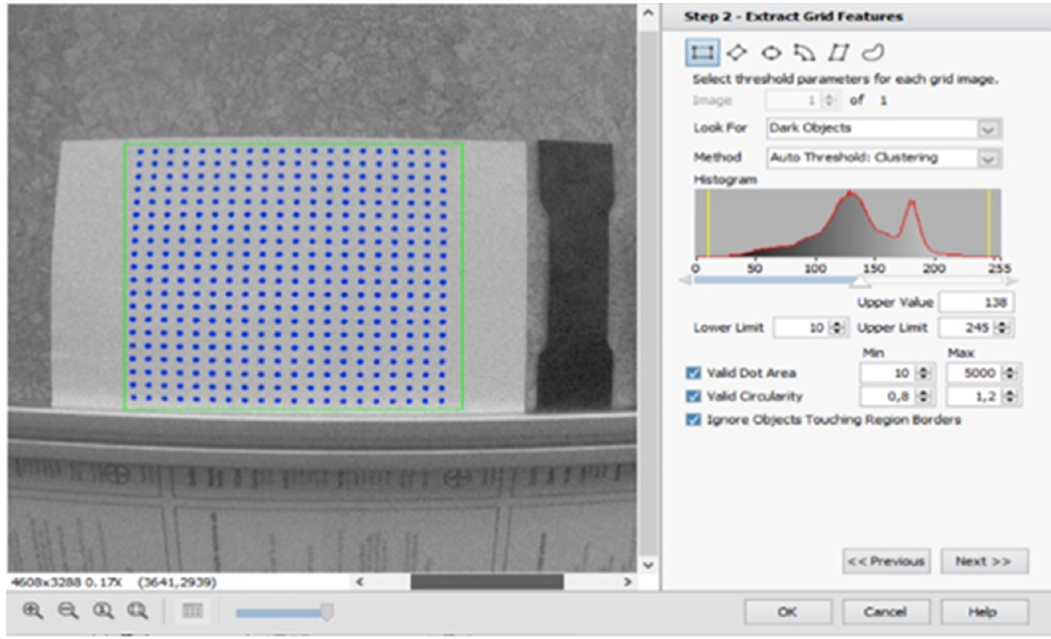
Figure 6. Calibration grid captured by camera.